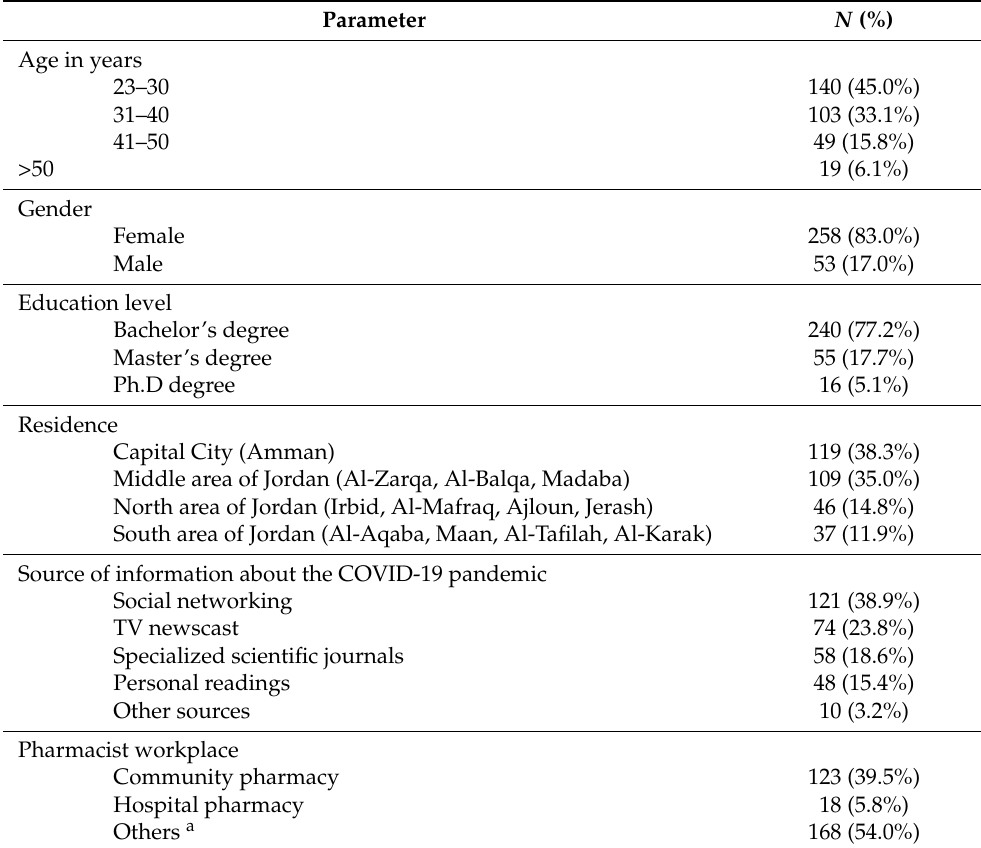
Table 1. Socio-demographic details of pharmacists who responded to the study questionnaire, ( N =